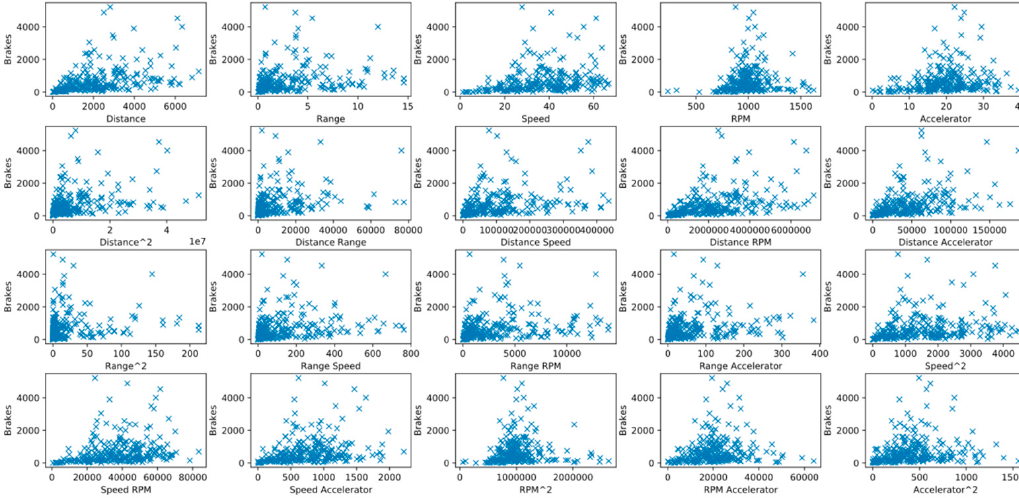
Figure 5. Relationship between “Brakes” and its independent variables.